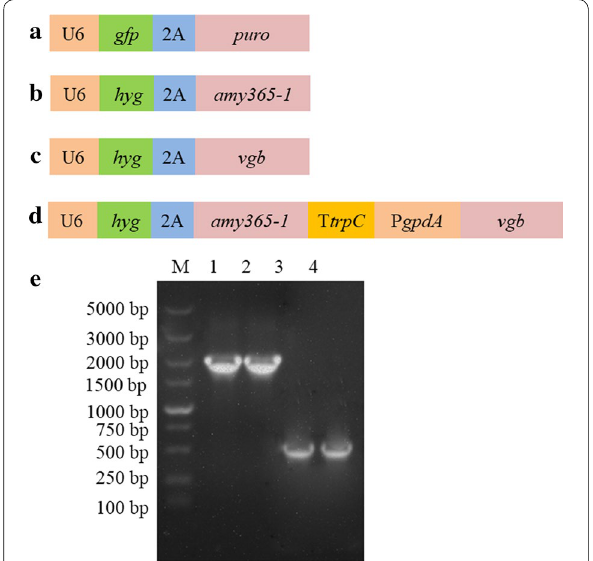
Fig. 1 Construction of expression vectors and cDNA of amy365 - 1 , vgb in this study. a Pgfppuro, b Phygamy365-1, c Phygvgb and d PhygPgpdAamy365-1-vgb. U6, U6 promoter; PgpdA, gpdA